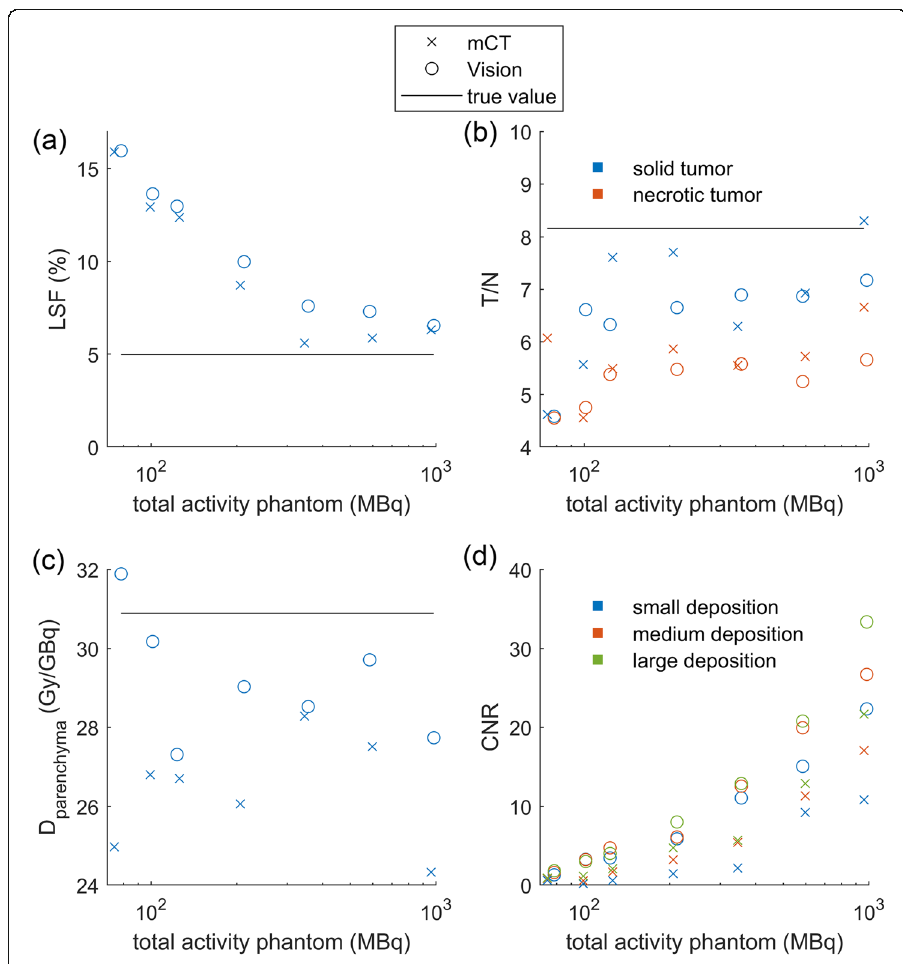
Fig. 5 Performance of the Vision and the mCT for measures concerning radioembolisation treatment planning: a lung shunt fraction (LSF), b tumour to non-tumour ration (T/N), c parenchymal dose ( D parenchymal ), and d contrast-to-noise ratio (CNR) of the extrahepatic